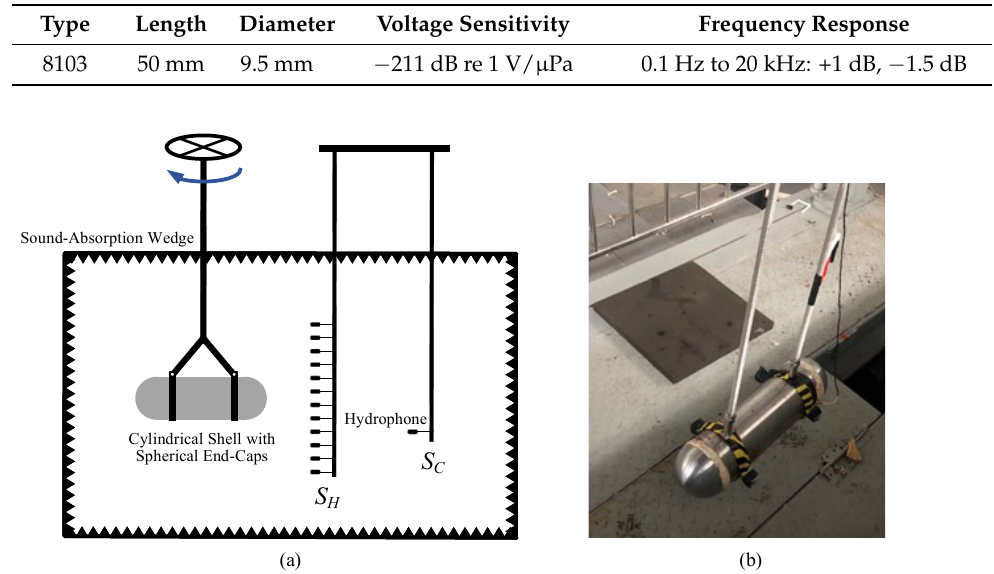
Table 1. The hydrophone parameters.